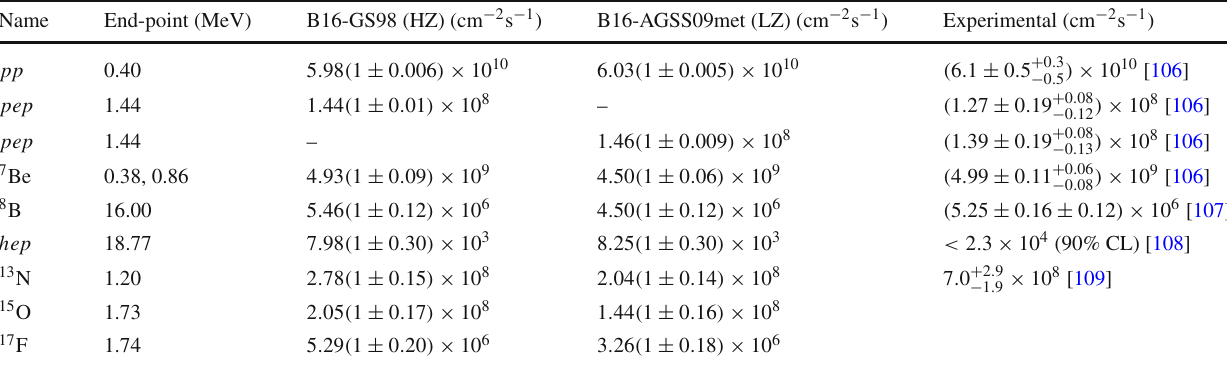
Table 3 List of the solar neutrino fluxes that are relevant for direct dark matter searches. HZ and LZ stand for “high-metallicity” and “low- metallicity”, respectively. Values for the B16 solar models are from Ref.